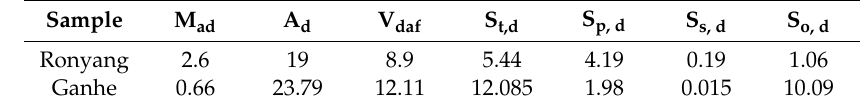
Table 2. Proximate analysis (%), total S and forms of S (%) in coals from the Rongyang and Ganhe mines. Sample